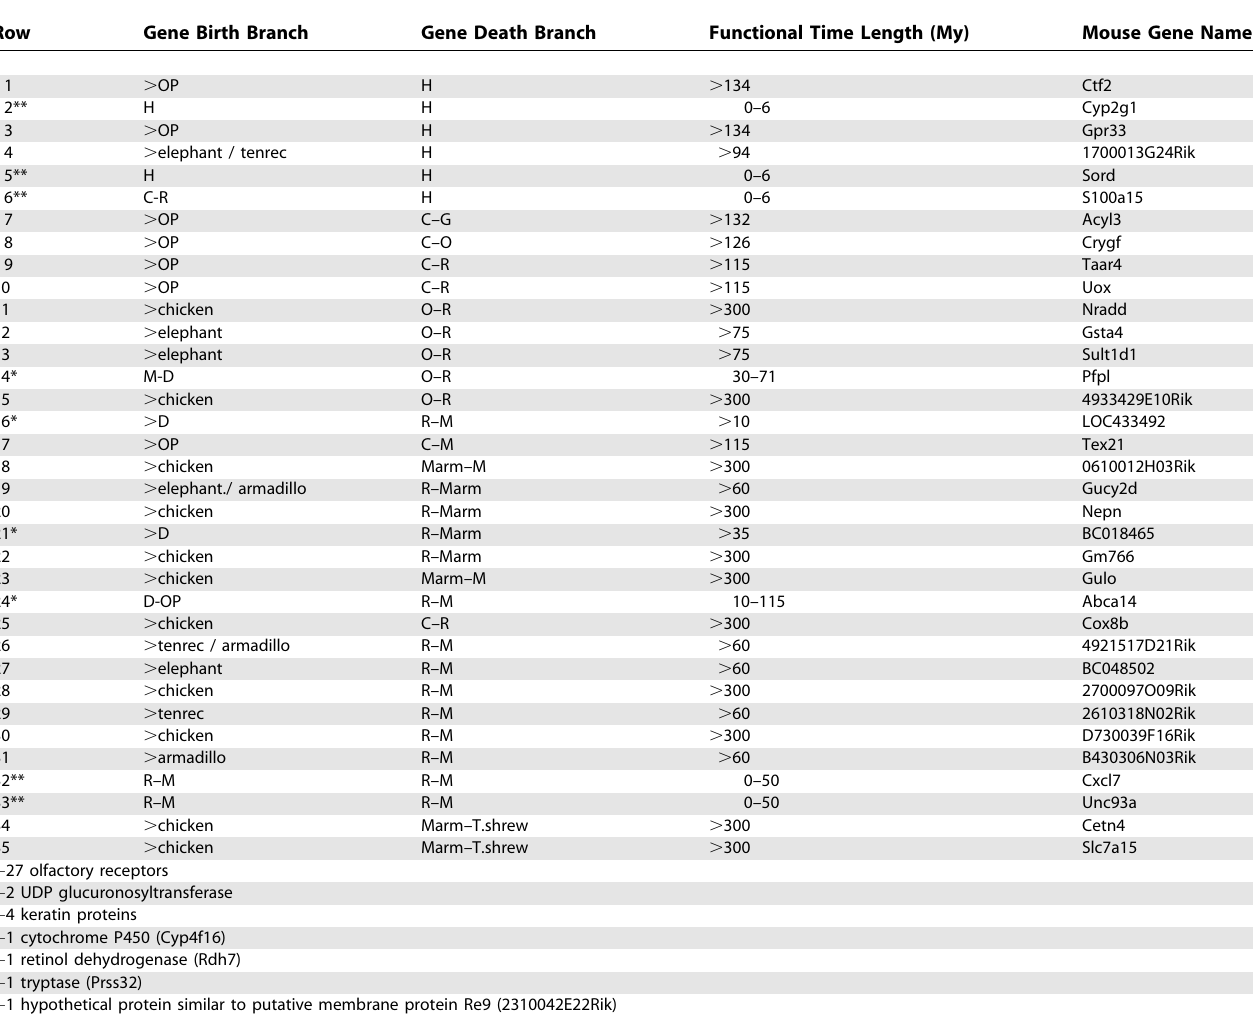
Table 2. Losses of Well-Established Genes in the Human Genome, Classified Using Estimated Functional Time Length